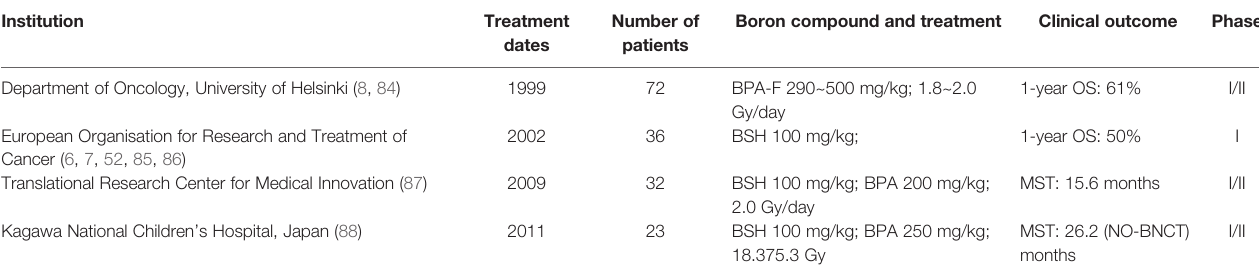
TABLE 3 | Clinical studies of BNCT application in